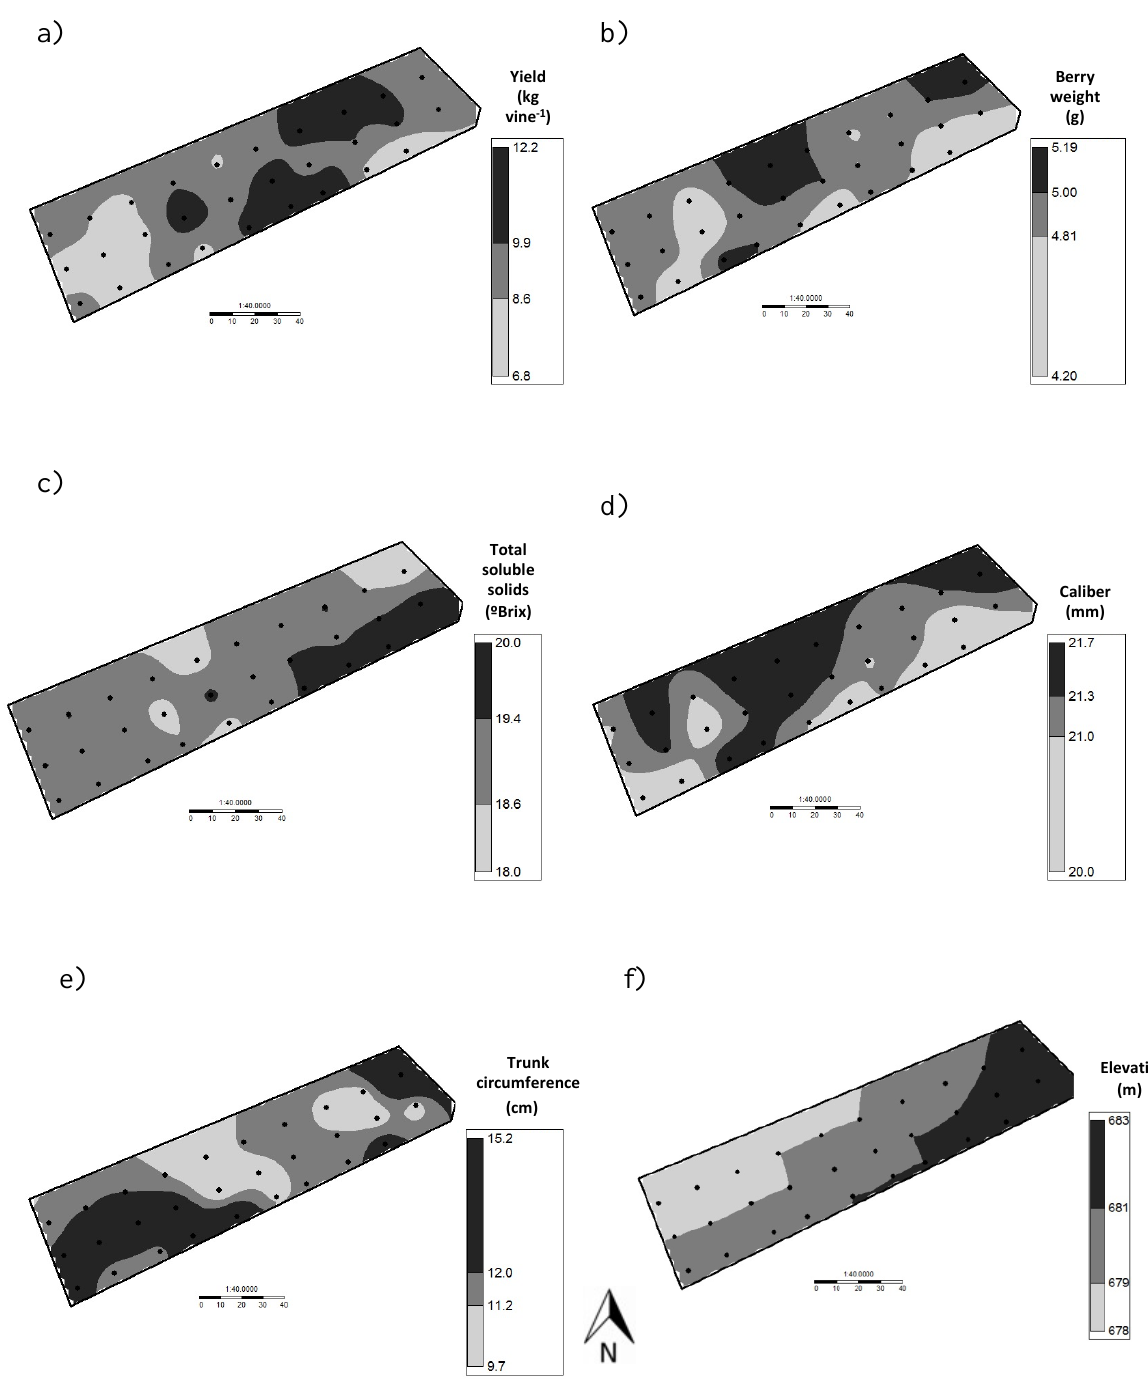
Figure 4. Maps of the main variables determined in table grapes cultivated in the flat plot. ( a ) Yield, ( b ), berry weight, ( c ) total soluble solids, ( d ) caliber, ( e ) trunk circumference, ( f ) elevation.